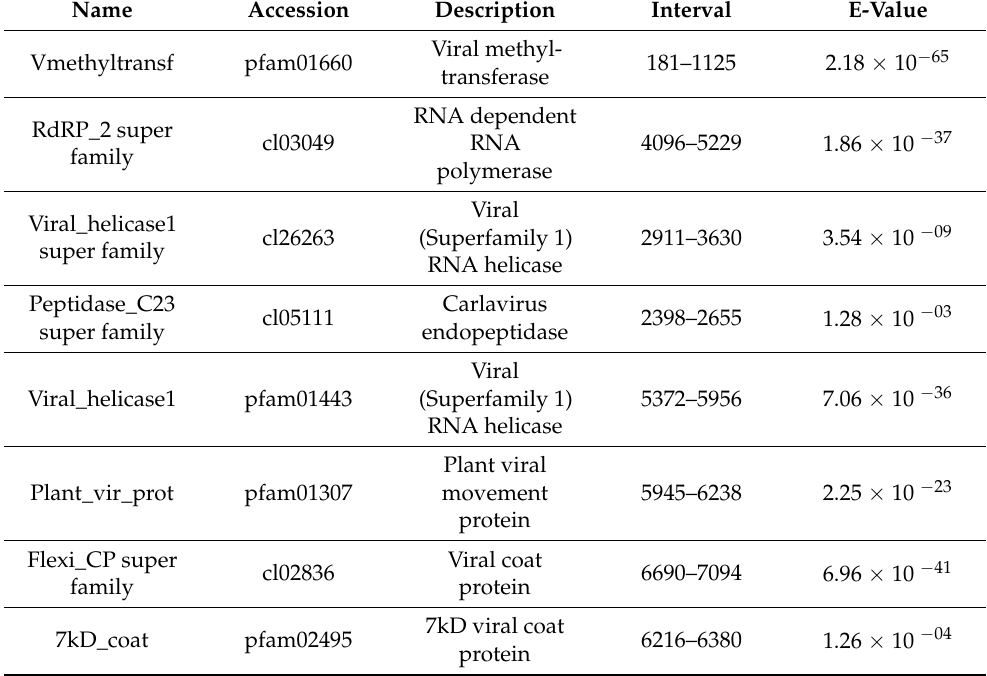
Table 5. List of conserved domains of the new species predicted by NCBI Conserved Domain Search.